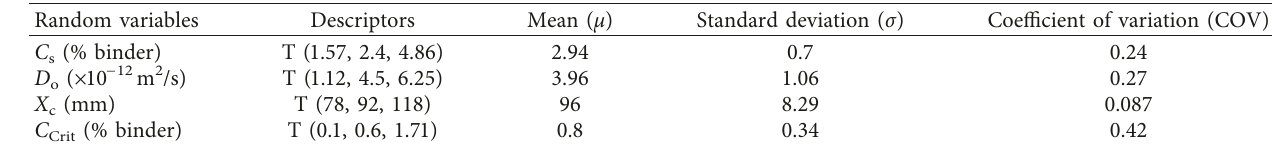
Figure 3: Raw data and proposed descriptors. (a) Surface chloride. (b) Diffusion coefficient. (c) Cover depth. (d) Critical chloride. Table 1: Proposed descriptors for four random variables.